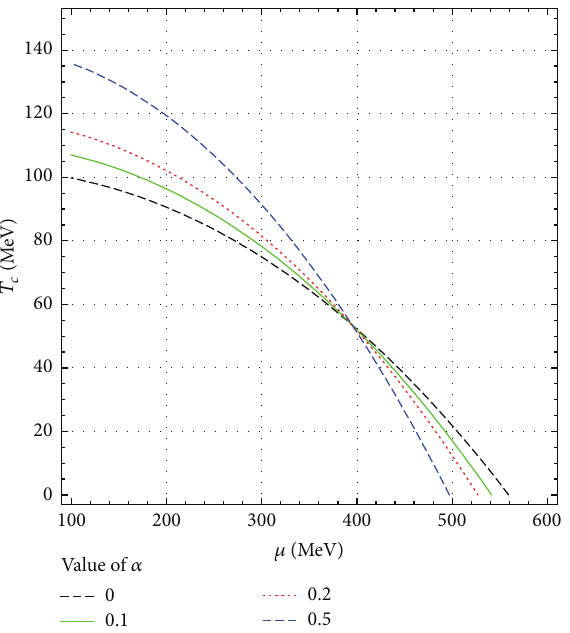
Figure 2: 𝑇 versus 𝜇 for various values of 𝛼